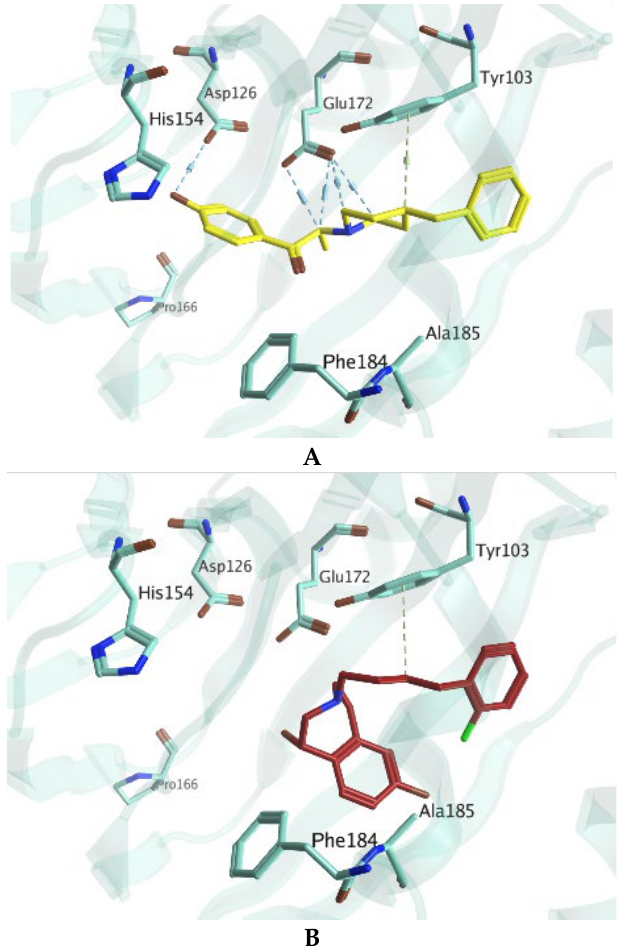
Figure 6. Predicted binding modes and possible interactions with σ1R of ifenprodil ( A ) and OF-NB1 ( B ). Ifenprodil and OF-NB1 are depicted in yellow and maroon, respectively.